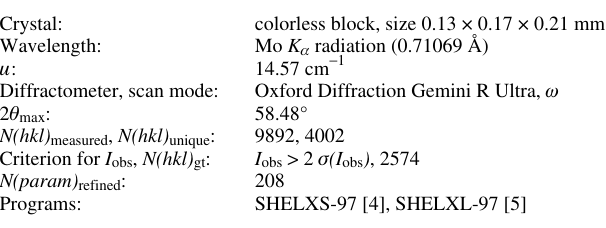
Table 1. Data collection and handling.